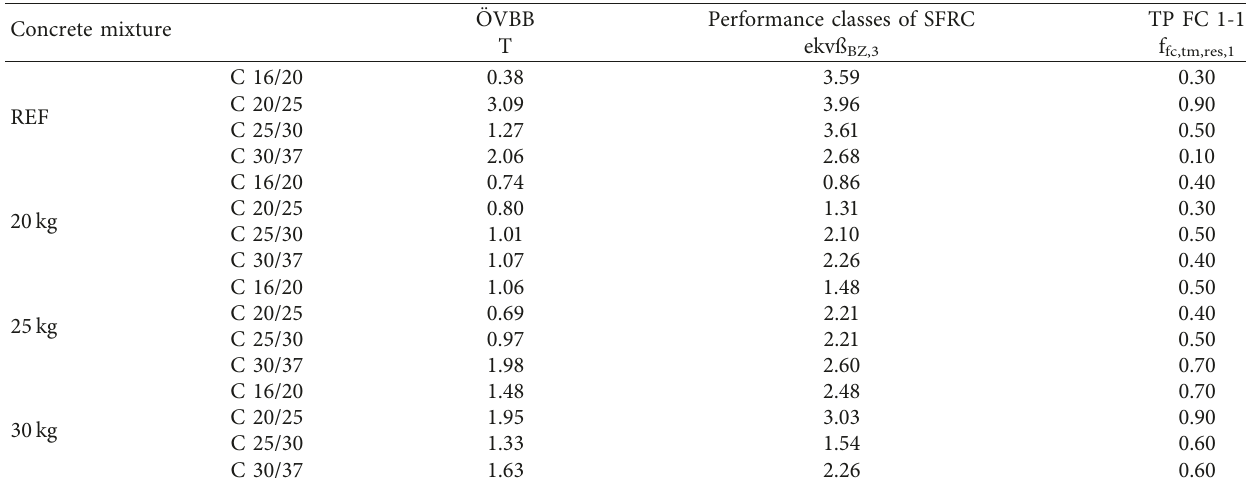
Table 6: Assessment of the residual tensile strength in bending at a deflection of 3.5 mm according to the Austrian Standard [16],